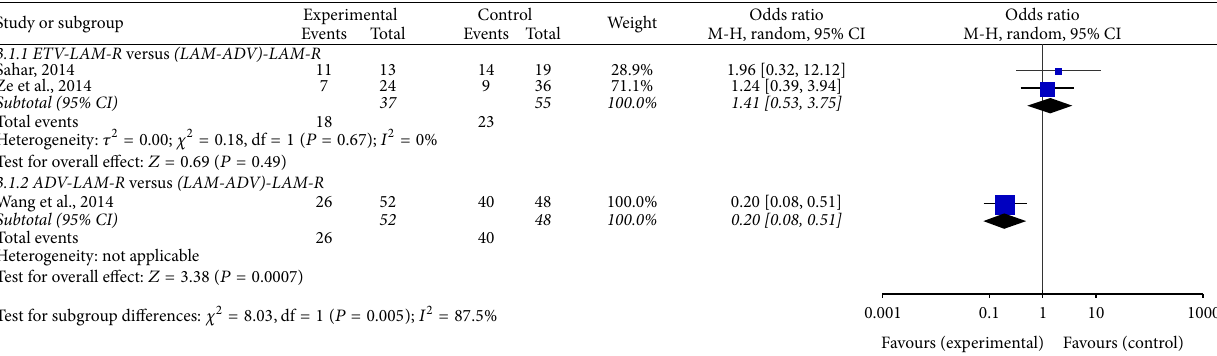
After 96-week treatment (Figure 2(b)), there was no sig- nificant difference in virological breakthrough and genotypic resistance between ETV and ADV (25% versus 13.6%; OR, 2.11; 95% CI: 0.60–7.46). However, ETV (22.9% versus 4.2%; OR, 5.98; 95% CI: 1.70–21.10) or ADV (26% versus 10.7%; OR, 3.22; 95% CI: 1.37–7.55) had higher rate of virological